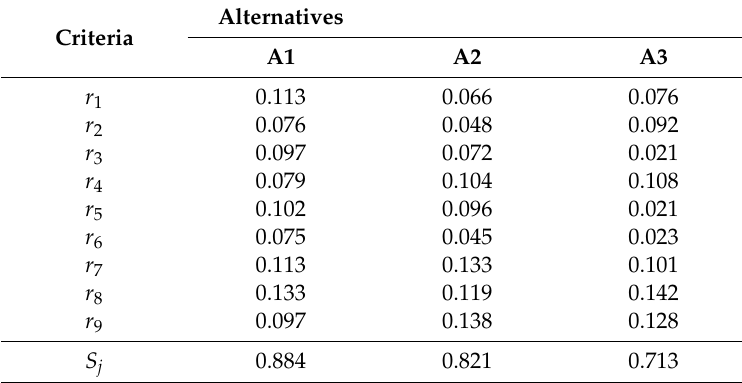
Table 7. Normalized-weighted criteria values r ij and the criterion S j of the weighted normalized values (SAW